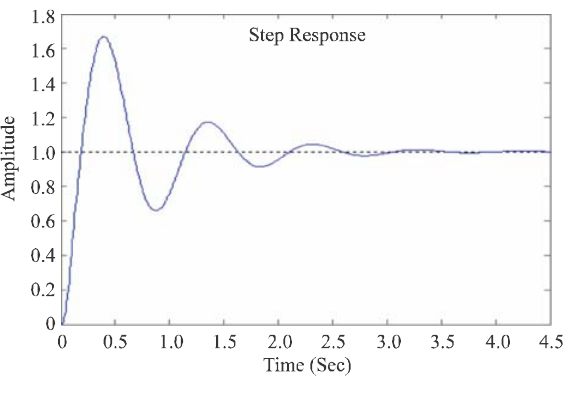
FIG. 7. STEP INPUT